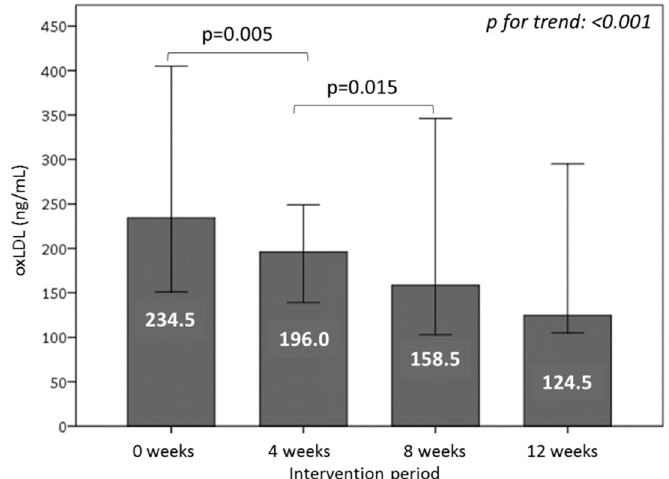
Figure 5. Oxidative damage to LDL, measured as plasma oxLDL concentrations of volunteers during the study. Volunteers consumed one WGPF-burger daily between weeks 0 and 4 (intervention period), followed by a washout period (weeks 4 to 8), and then consumed one control-burger daily between weeks 8 and 12 (control period). Bars represent the mean value for each time; lines represent the 95% confidence interval. The Friedman test was used to evaluate changes between the 4-week intervention periods over time. LDL: low-density lipoprotein; oxLDL: oxidized low-density lipoprotein.